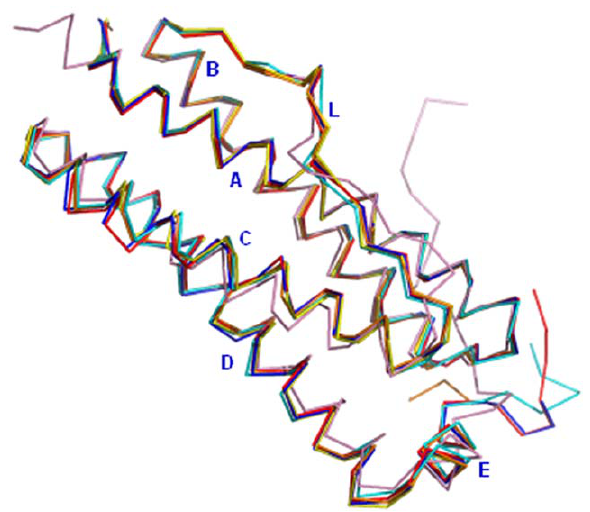
Figure 3. Conserved architecture of Mtb BfrA. Superposition of Mtb SeMet-BfrA (Chain D, shown in blue) with monomers of bacterioferritins from other prokaryotes. The PDB ID followed by the Chain ID used for superposition and the color of the monomer is given in parenthesis. M. smegmatis (3bkn:A; red), E. coli (2htn:H; orange), A. vinelandii (1sof:E; yellow), R. capsulatus (1jgc:A; cyan) and D. desulfur- icans ((1nf6:M; pink). Also the five helices (A–E) and the L-loop are labeled in